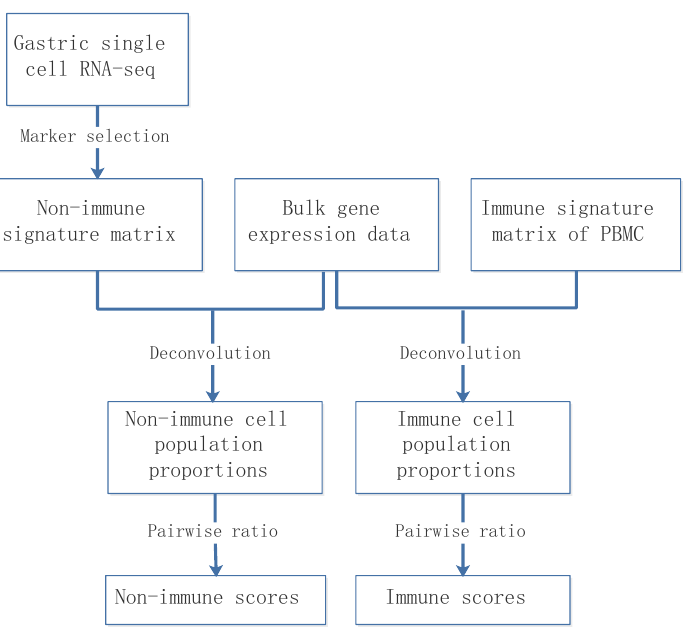
Figure 3. Schematic of the deconvolution of heterogeneous tissue